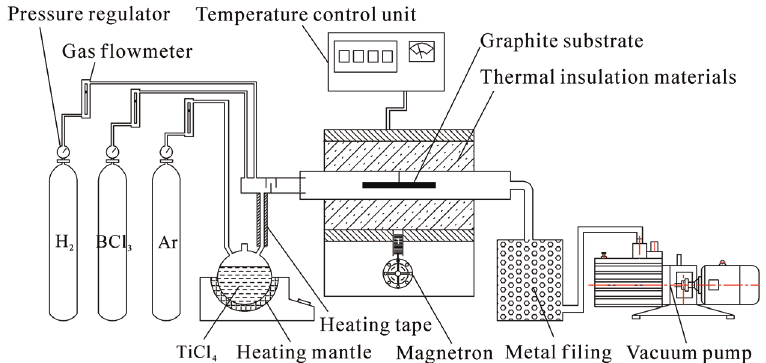
Figure 1: Schematic diagram of the microwave heating CVD system.